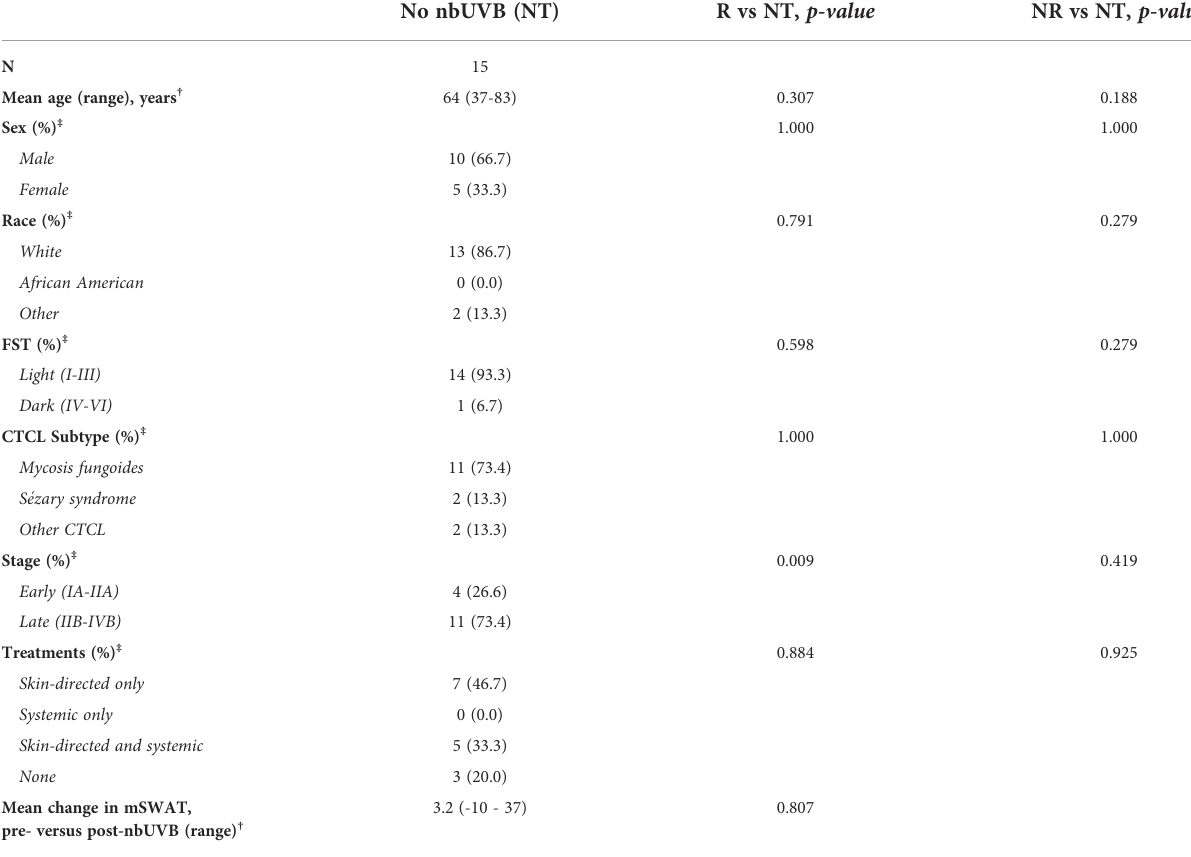
TABLE 2 Demographic and clinical characteristics of patients not treated with nbUVB (NT) compared to nbUVB responders (R) and non- responders